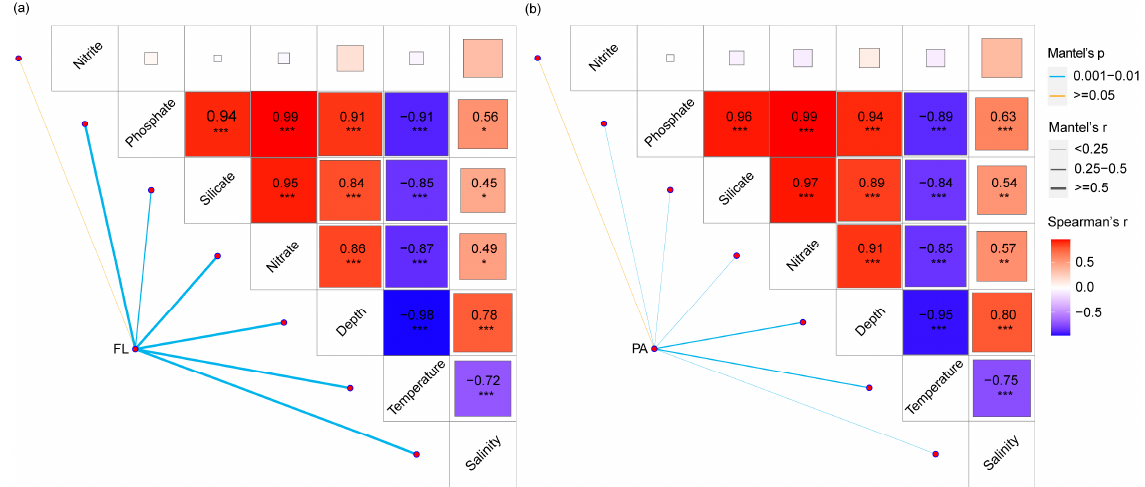
Figure 4. Environmental drivers of bacterioplankton community in continental shelf and slope regions evaluated by Mantel tests. Edge width corresponds to R value and edge color indicates statistical significance. Color gradient repre- sents Spearman correlation coefficients between environmental variables. Asterisks indicate significance (* p < 0.05; ** 0.05 < p < 0.01; *** p < 0.01). ( a ) Free-living community. ( b ) Particle-associated community.